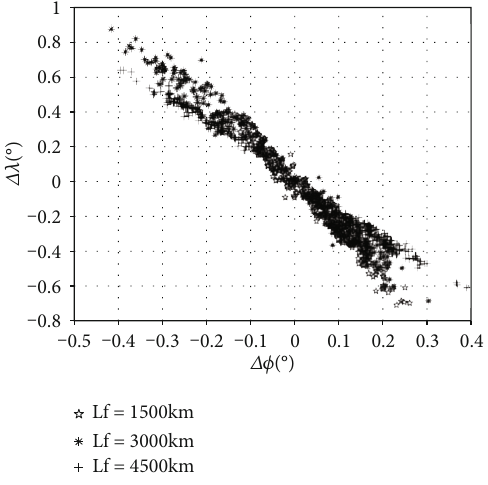
Figure 10: Drogue deployment accuracy under the proposed guidance